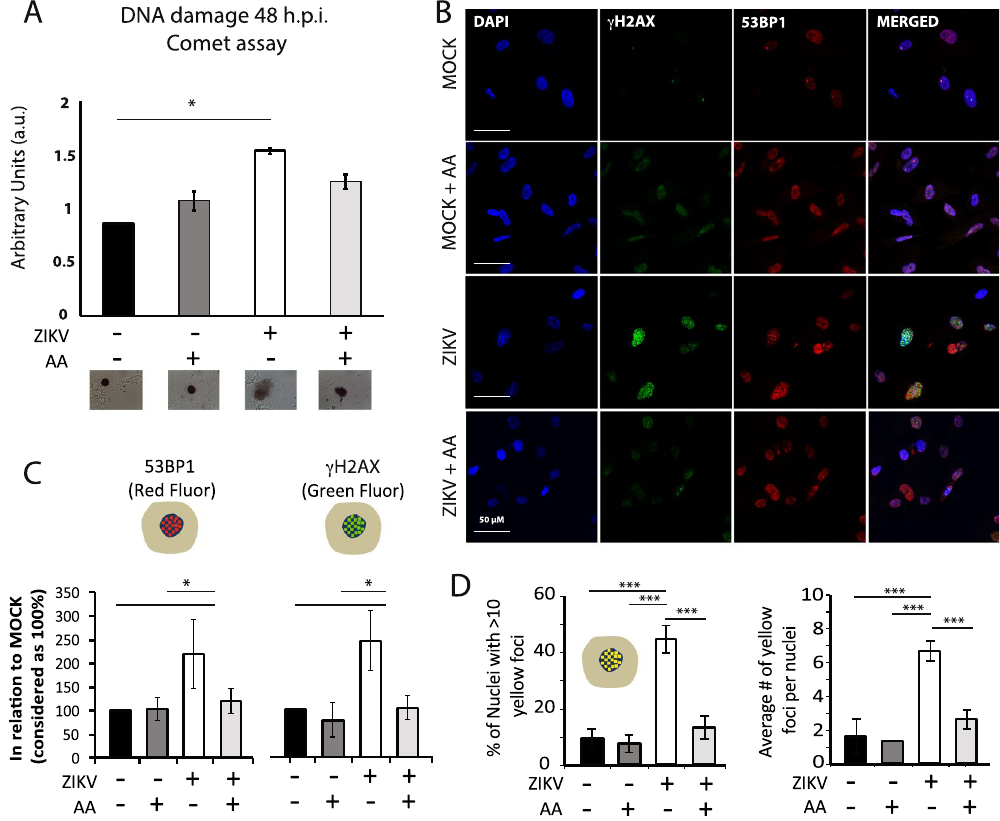
Figure 5. Ascorbic acid attenuates DNA damage. ( A ) Alkaline comet assay. N = 4. * p = 0.02. ( B ) Ascorbic acid treatment in ZIKV-infected astrocytes, stained for DDR proteins γ H2AX and 53BP1. ( C ) Quantification of γ H2AX and 53BP1 fluorescence levels in MOCK- and ZIKV-infected astrocytes treated and untreated with ascorbic acid. Over 200 nuclei were quantified per condition. Scale bar: 50 µ M. ( D ) Number co-localized foci of γ H2AX and 53BP1 were quantified in the same astrocyte nuclei analyzed in C. * p < 0.05, *** p < 0.001. Astrocytes derived from iPSC lines GM23279A, CF1 and C15 were